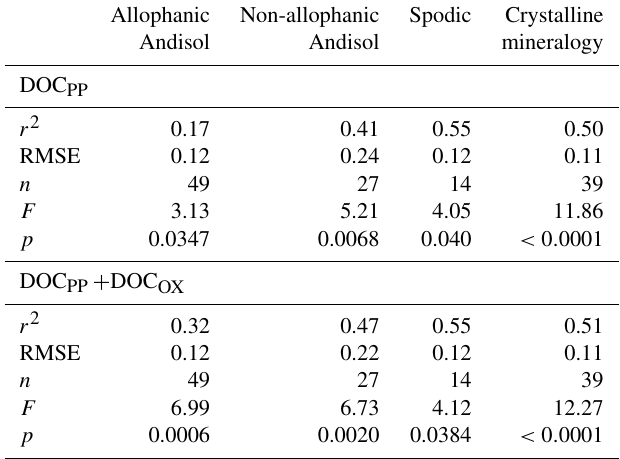
Table A2. The results of a cubic polynomial regression model applied to each of the four soil groups for pyrophosphate-extractable organic C (DOC PP ) and the sum of pyrophosphate- and oxalate-extractable C (DOC PP + DOC OX